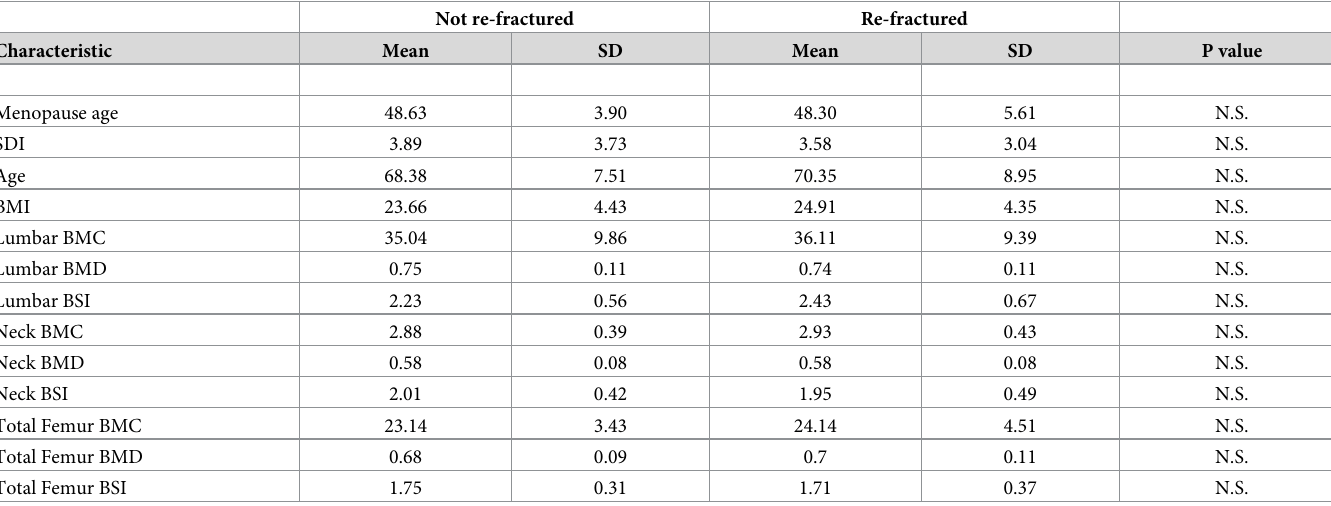
Table 2. Characteristics of the two groups of patients, fractured vs not fractured.